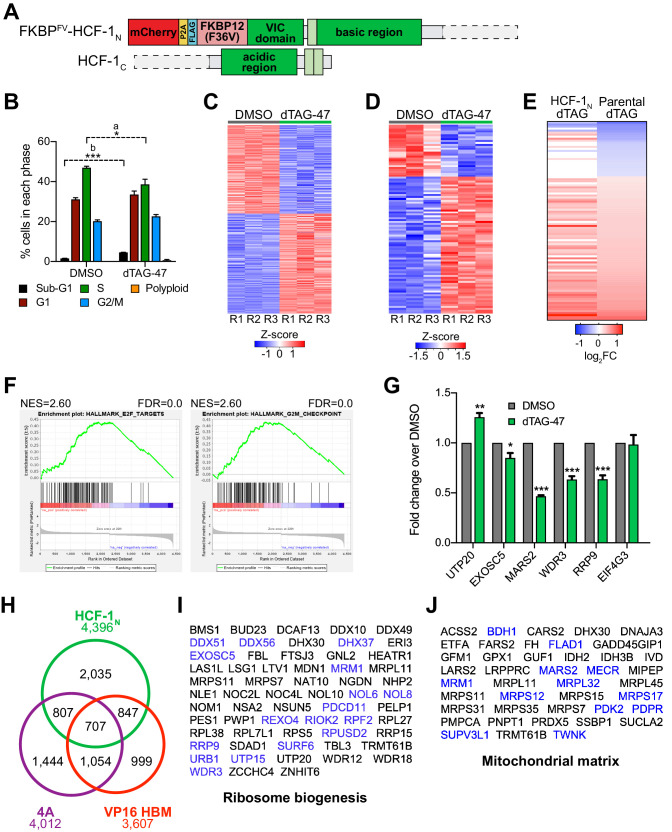
Inducible degradation of host cell factor (HCF)–1N.(A) Schematic of the HCF-1 fusion protein in Ramos FKBPFV-HCF-1N Ramos cells, which were generated using CRISPR/Cas9 homology-directed repair. Fused to the N-terminus of the VP16-induced complex (VIC) domain is mCherry linked by P2A to FLAG-tagged FKBP12FV. (B) Cell cycle distribution was determined using propidium iodide (PI) staining of FKBPFV-HCF-1N Ramos cells treated with DMSO or 500 nM dTAG-47 for 24 hr. Shown are the mean and standard error for three biological replicates. Student’s t-test was used to calculate p-values; a = 0.037, b < 0.0001. (C) Heatmap of significantly (false discovery rate [FDR] < 0.05) changed transcripts in FKBPFV-HCF-1N Ramos cells treated with DMSO or dTAG-47 for 3 hr. Shown are the z-transformed expression data for three biological replicates of RNA-Seq, ranked by fold-change (FC). (D) Heatmap of significantly (FDR < 0.05) changed transcripts in parental Ramos cells treated with DMSO or 500 nM dTAG-47 for 3 hr. Shown are the z-transformed expression data for three biological replicates of RNA-Seq, ranked by FC. (E) Heatmap showing the log2FC of all transcripts that are significantly (FDR < 0.05) changed when untagged Ramos cells were treated with DMSO or dTAG-47 for 3 hr, and the corresponding log2FC data in FKBPFV-HCF-1N Ramos cells. (F) Gene set enrichment analysis (GSEA) of significantly (FDR < 0.05) changed transcripts in FKBPFV-HCF-1N Ramos cells. Shown are the normalized enrichment scores (NES) and FDR for each gene set. (G) Validation of select RNA-seq changes in FKBPFV-HCF-1N Ramos cells. Cells were grown with DMSO or dTAG-47 for 3 hr, RNA isolated, RT-qPCR performed, and Ct values normalized to those for GAPDH. Fold-changes were then calculated over DMSO-treated samples. Shown are the mean and standard error for three biological replicates. Student’s t-test between DMSO and dTAG-47-treated cells was used to calculate p-values. *p<0.05, **p<0.01, ***p<0.001. (H) Venn diagram showing overlap of gene transcripts that are significantly (FDR < 0.05) changed in RNA-Seq with the 4A and VP16 HCF-1-binding motif (HBM) mutants, and with degradation of HCF-1N in Ramos cells. (I and J) Transcripts that are decreased with the 4A MYC mutant and increased with the VP16 HBM MYC mutant and fall into the ‘Ribosome biogenesis’ (I) or ‘Mitochondrial matrix’ (J) gene ontology categories. Highlighted in blue are the genes that are also significantly decreased with degradation of HCF-1N.